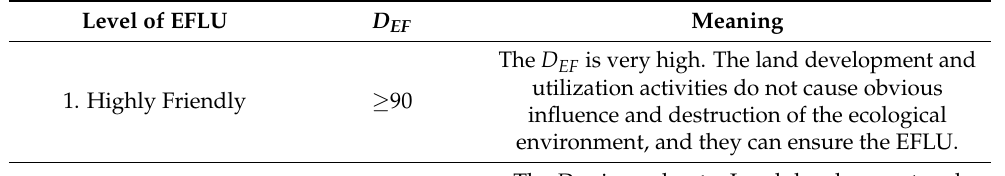
Table 4. Grading Standard and Basic Meaning of EFLU.